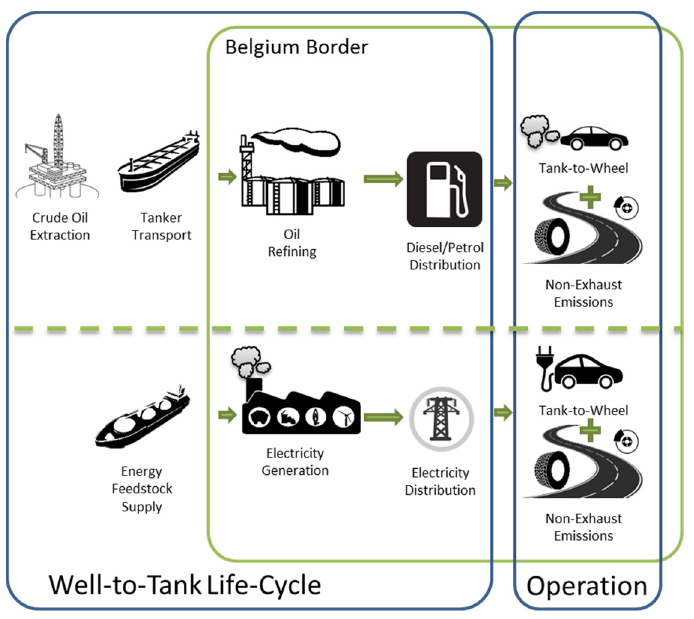
Figure 6. System boundaries.